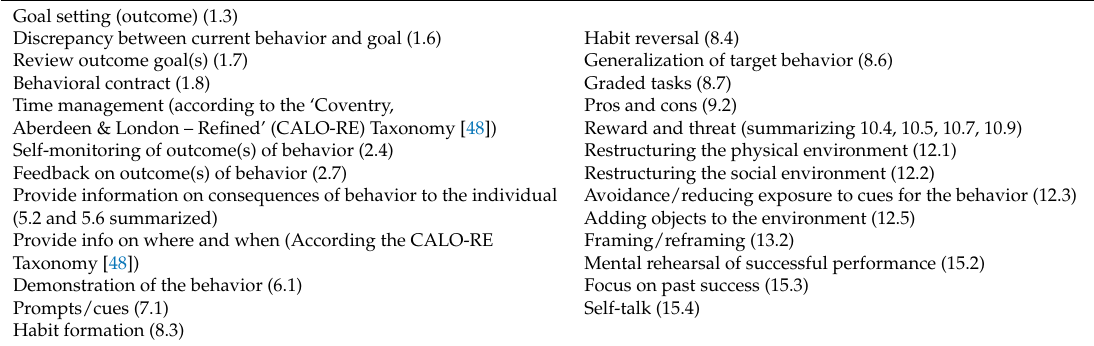
Adding objects to the environment (12.5) Framing/reframing